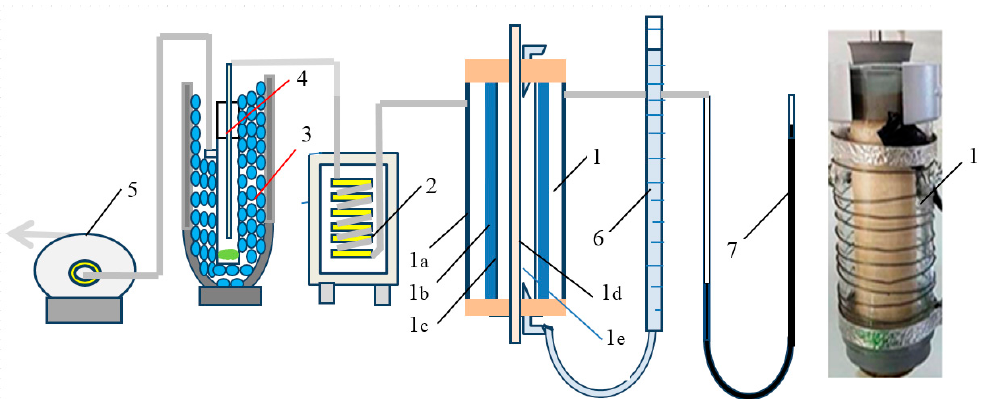
Figure 3. Laboratory equipment for pervaporation studies with rigid membranes deposited on the external surface of a ceramic tube: ( 1 ) pervaporation unit, (1 a ) glass tube, (1 b ) PVA-BC membrane, (1 c ) ceramic support, (1 d ) tube for heating the processed liquid, (1 e ) ethanol-water mixture, ( 2 ) electric cooler, ( 3 ) Dewar vessel with crushed ice, ( 4 ) steam condenser with central tube, ( 5 ) vacuum pump, ( 6 ) precision burette for measuring the permeate flow rate, ( 7 ) mercury manometer.